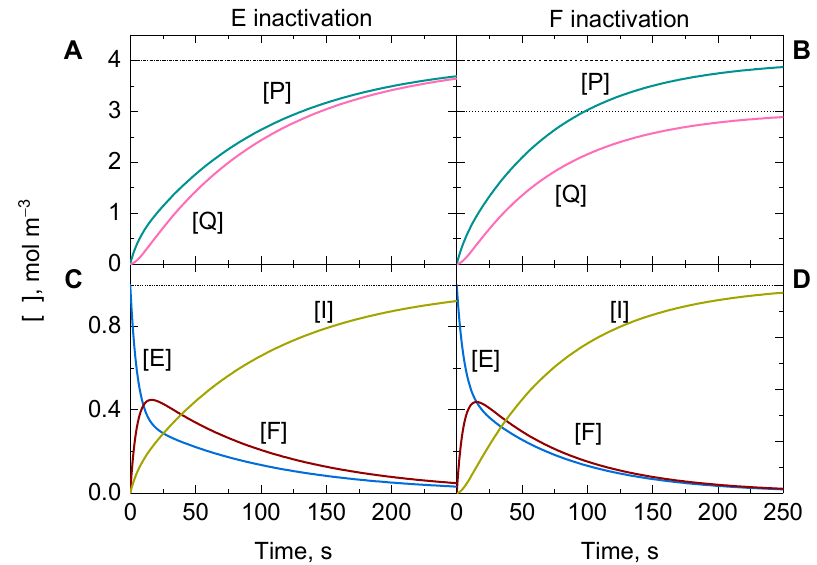
Figure 6. Representative approximate analytically integrated solutions of the time-dependent variation of the concentration for ( A , B ) the products P and Q and ( C , D ) the two active enzyme states E and F, together with the inactivated state I, of a ping-pong reaction under non-steady-state conditions, in which the suicide substrate A undergoes disproportionation and inactivates ( A , C ) E or ( B , D ) F, while its concentration remains constant (i.e., [ A ] = [ A ] ). Horizontal dashed, dotted, and short dashed lines are the limit values for [ P ] , [ Q ] , and [ I ] as the time approaches infinity, respectively. Initial conditions: [ A ] = 5 mol · m − 3 , [ E ] = 1 mol · m − 3 , k a = 2 × 10 − 2 m 3 · ( mol · s ) − 1 , k = 1.5 × 10 − 2 m 3 · ( mol · s ) − 1 , d 0 0 and k i = 5 × 10 − 3 m 3 · ( mol s ) − 1